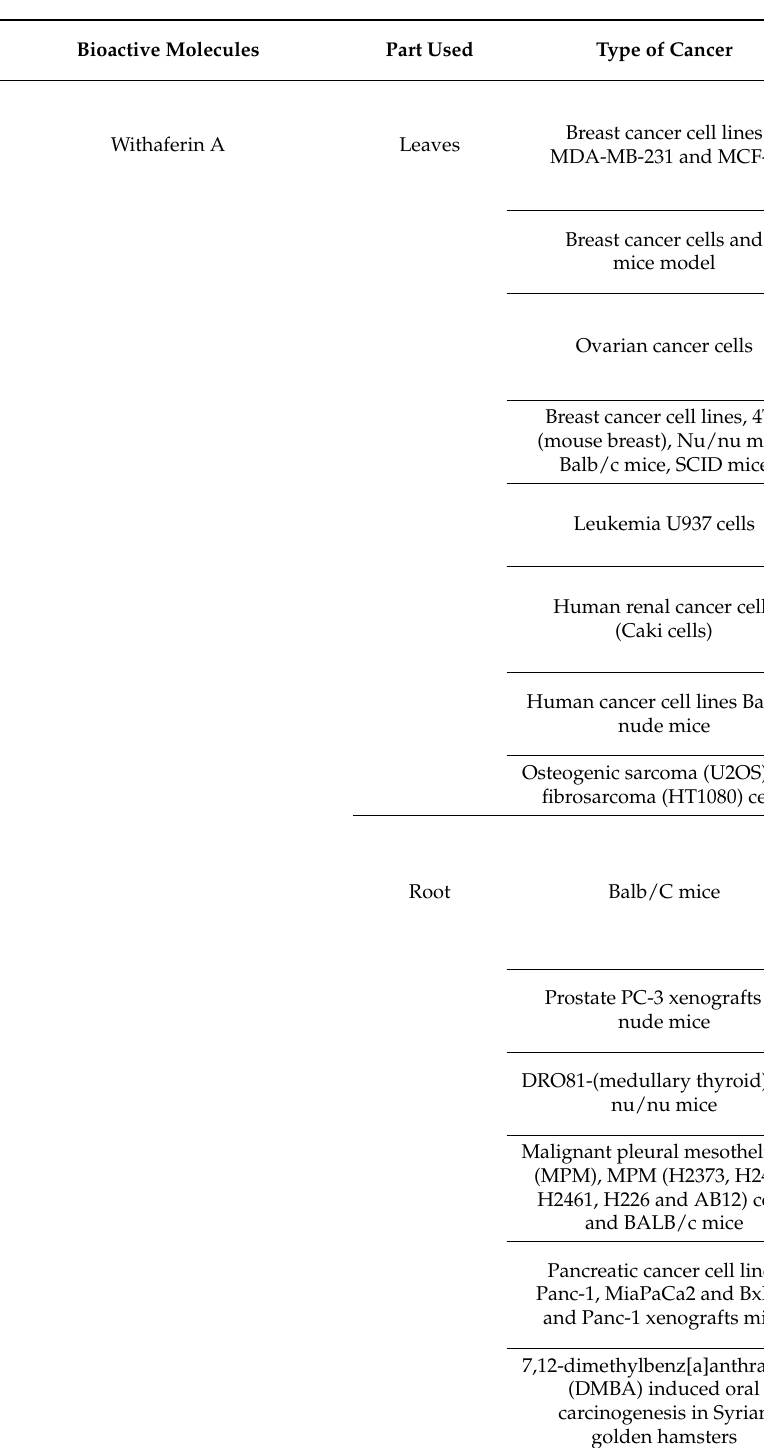
Table 1. Different bioactive molecules of Withania somnifera and their anticancer